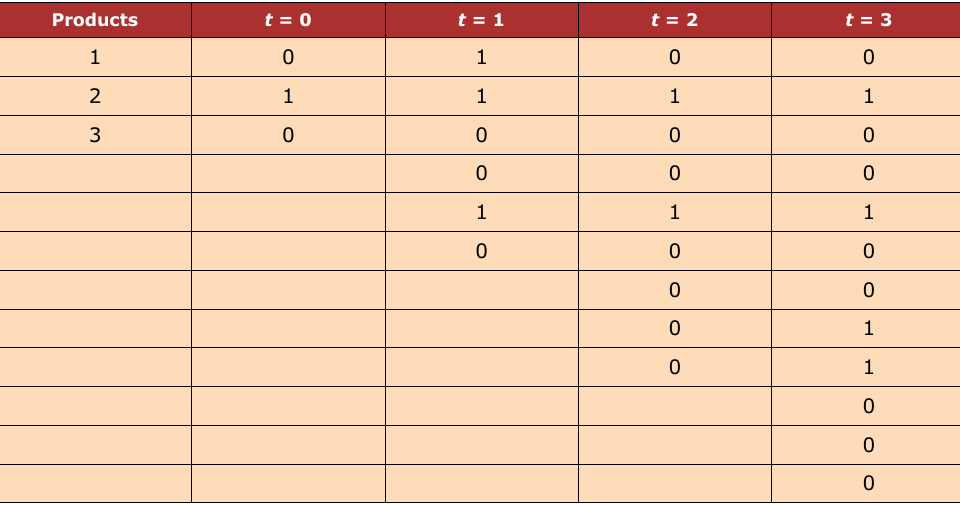
Table 5. The Optimal Strategy for Product